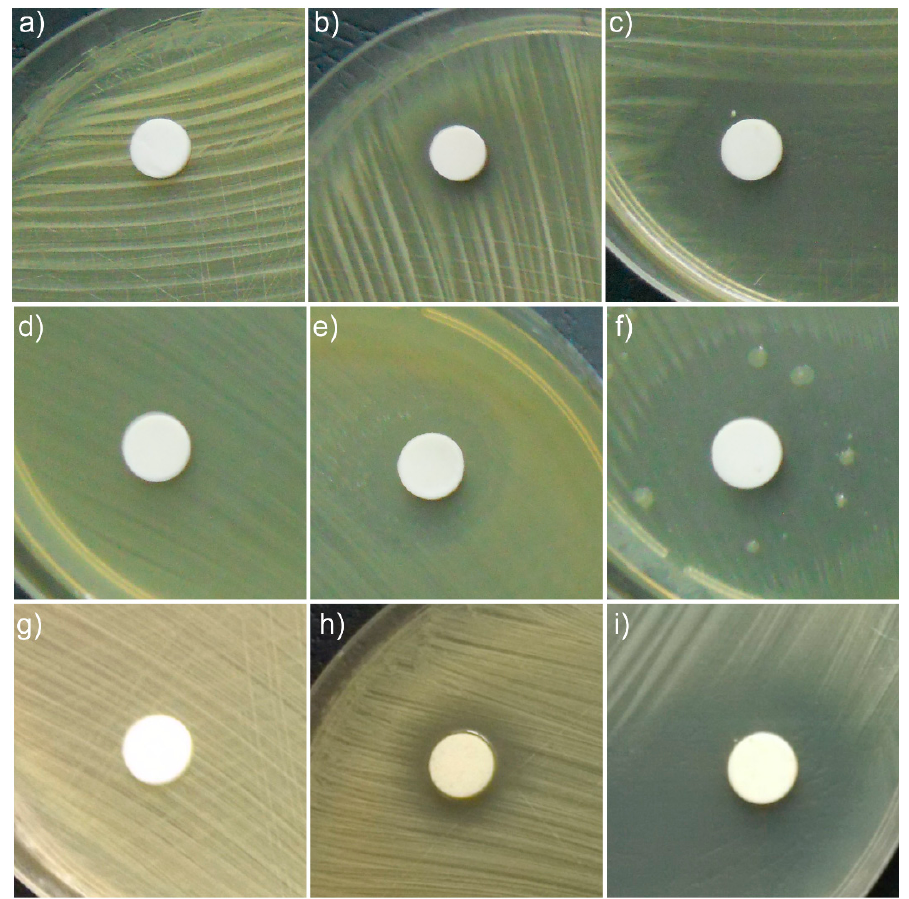
Figure 7. Qualitative assay of the inhibitory activity of HAp, HAp-B and HAp-L samples